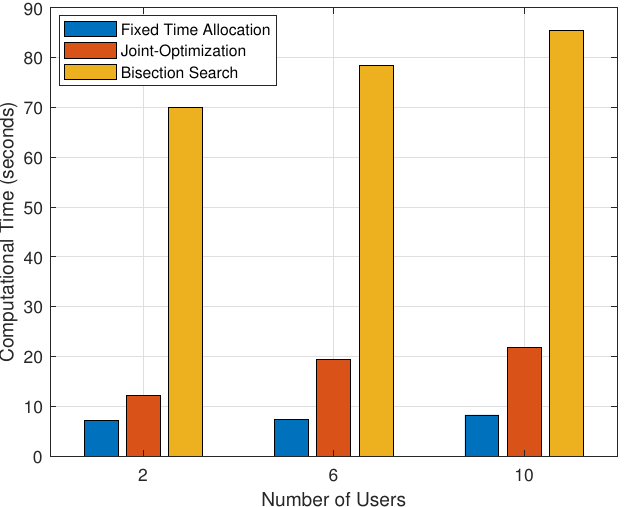
Figure 6. Computation time comparisons versus the number of users.